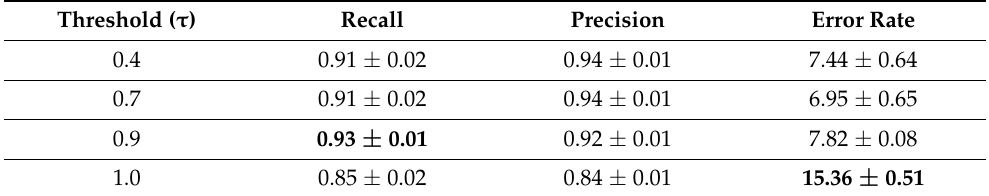
Table 10. Test set metrics of the PCB_SS model using different thresholds ( τ ) (Best result in